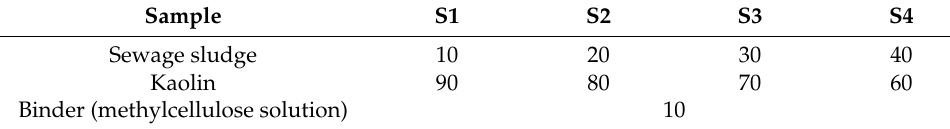
Table 2. Designed proportions of kaolin-sewage sludge ceramic bricks